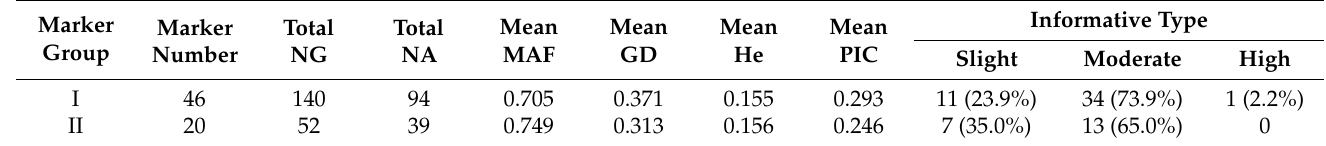
Table 2. Summary of SNP marker genetic diversity parameters of 432 pea accessions after